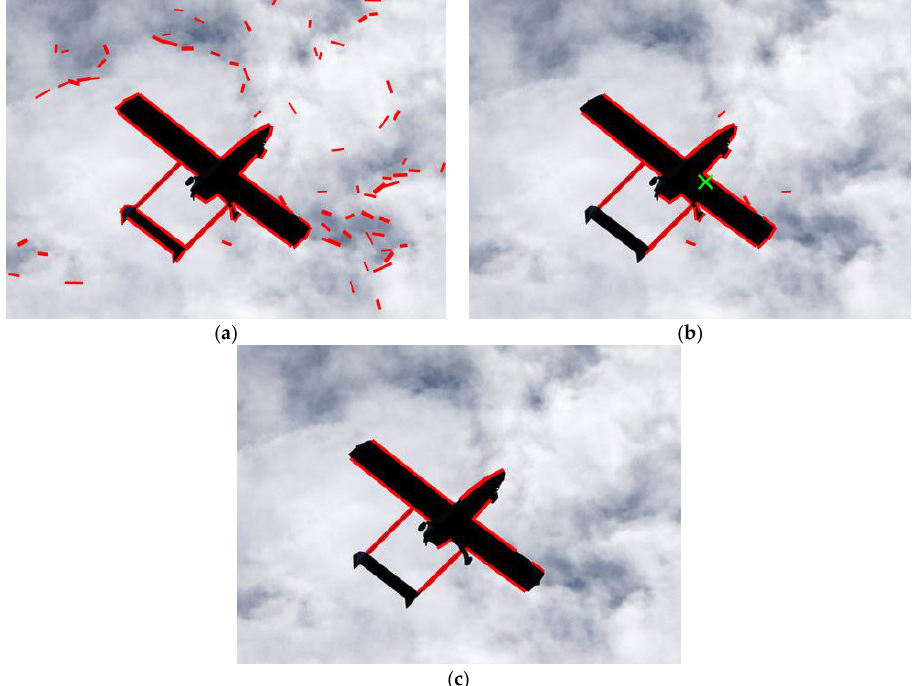
Figure 2. The results of line feature extraction and line clustering based on spatial and length consistency: ( a ) Line feature extraction; ( b ) Spatially consistent line clustering; ( c ) Length-consistent line clustering.